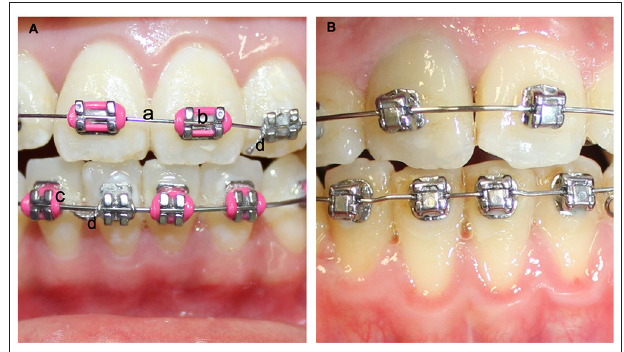
FIGURE 4 | (A) Methods to secure archwire to conventional brackets. (a) archwire, (b) bracket, (c) elastomeric tie to secure archwire in place, (d) ligature tie to secure archwire; (B) self-ligating